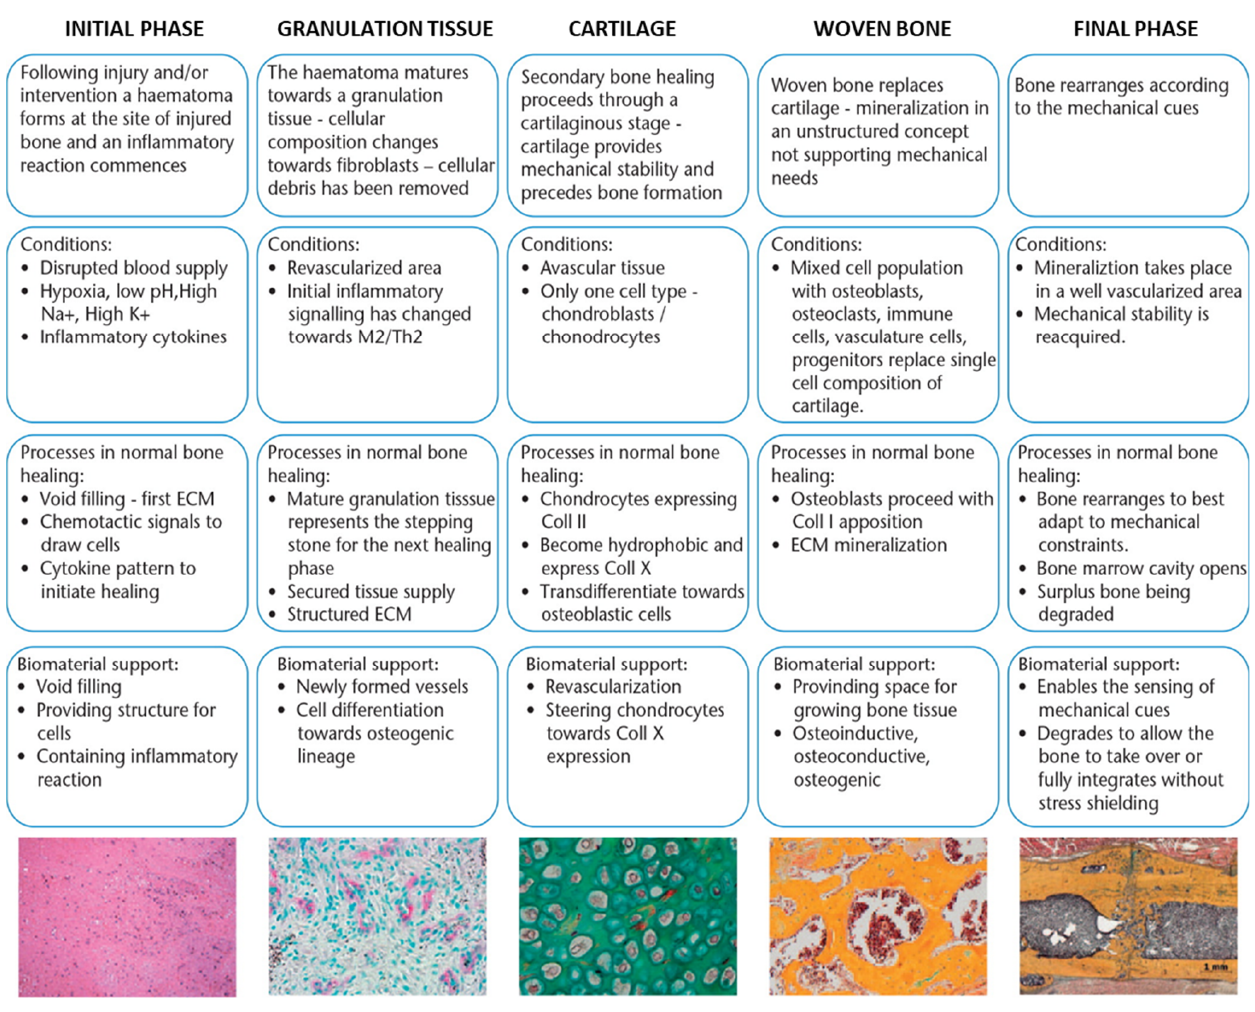
Figure 2. Phases of bone growth on biomaterial and necessary support features. Modified from [37] Creative Commons CC-BY license.